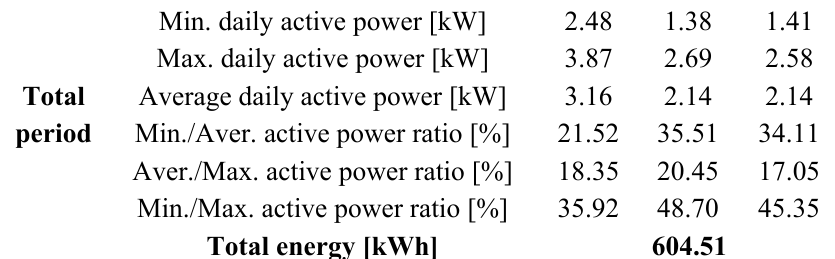
Table 4. Total AC active power consumption